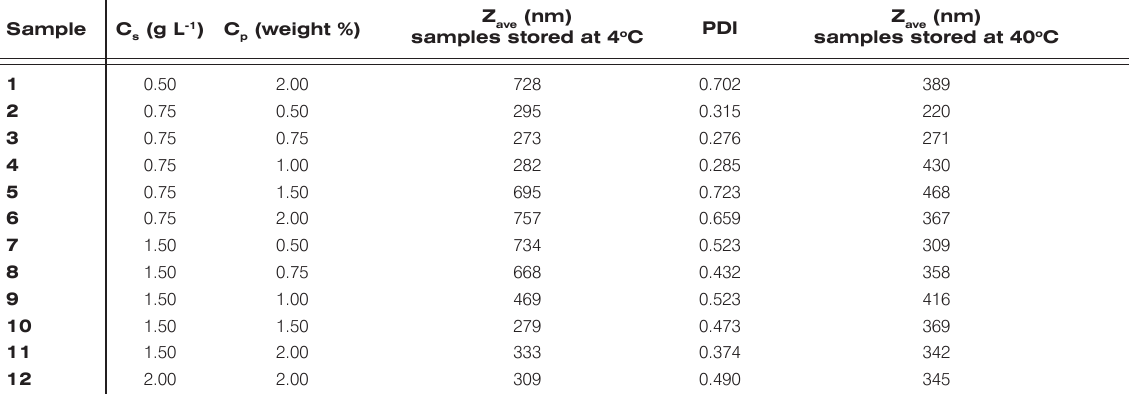
Table 2. Supplementary experimental data added to the input file for training and testing the neural networks.